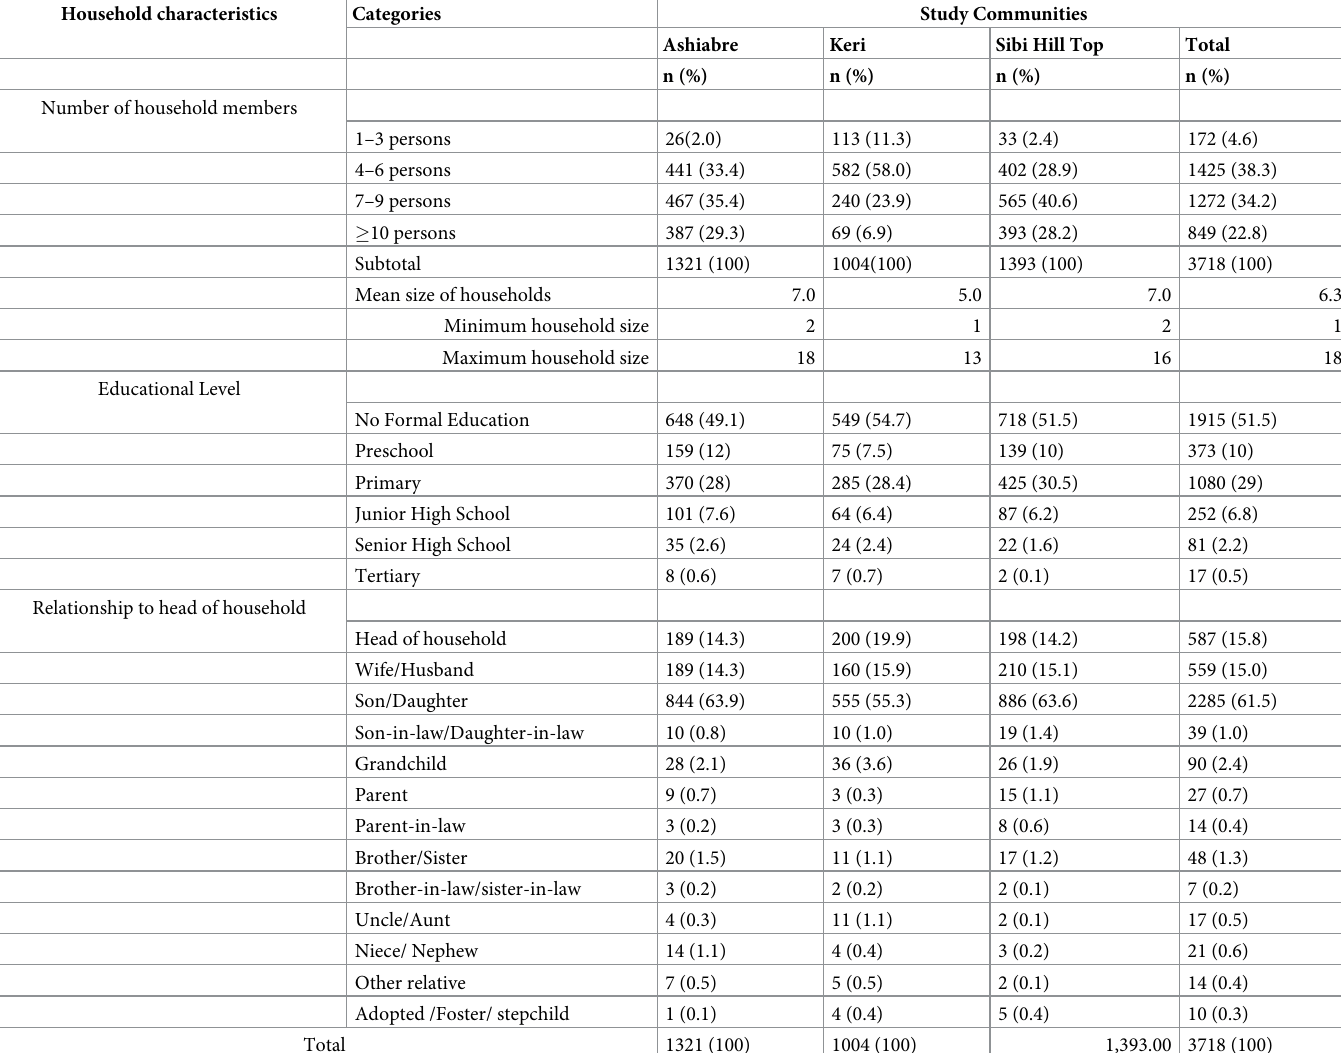
Table 2. Household composition by the number of usual household members, educational level, and relationship to head of